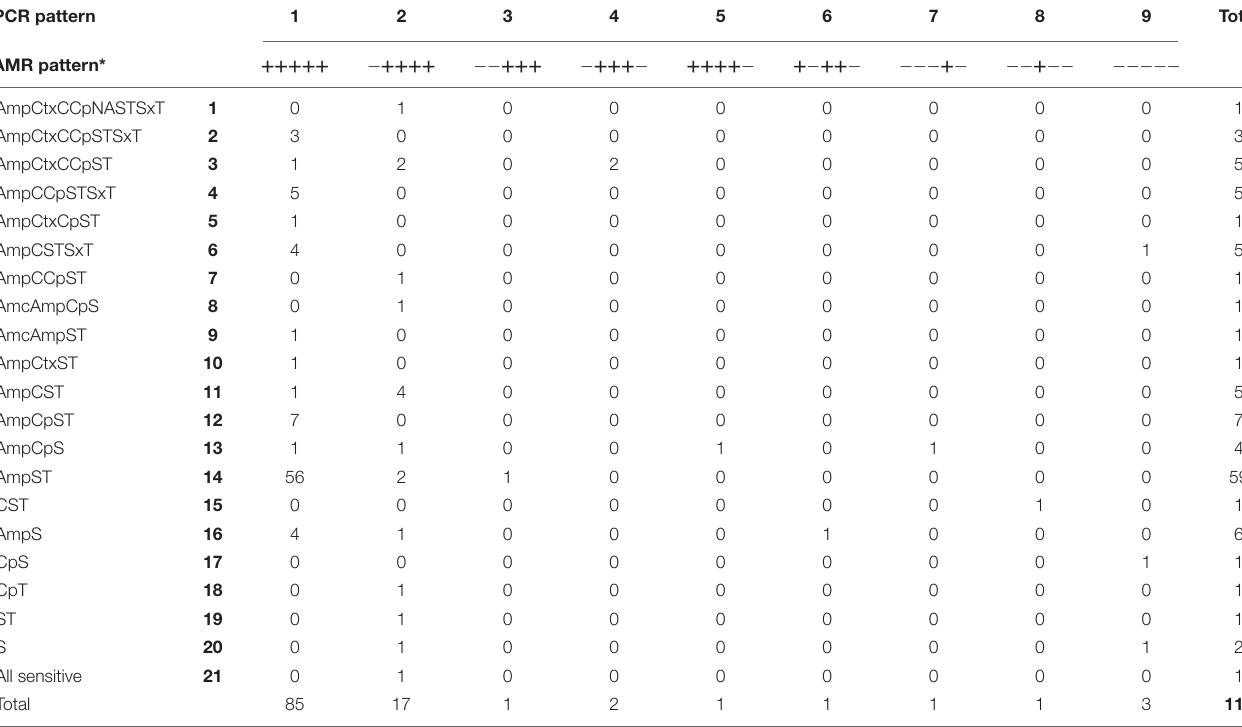
TABLE 3 | AMR patterns in relation to PCR patterns in S . 4,5,12:i:- isolates ( n = 112). PCR